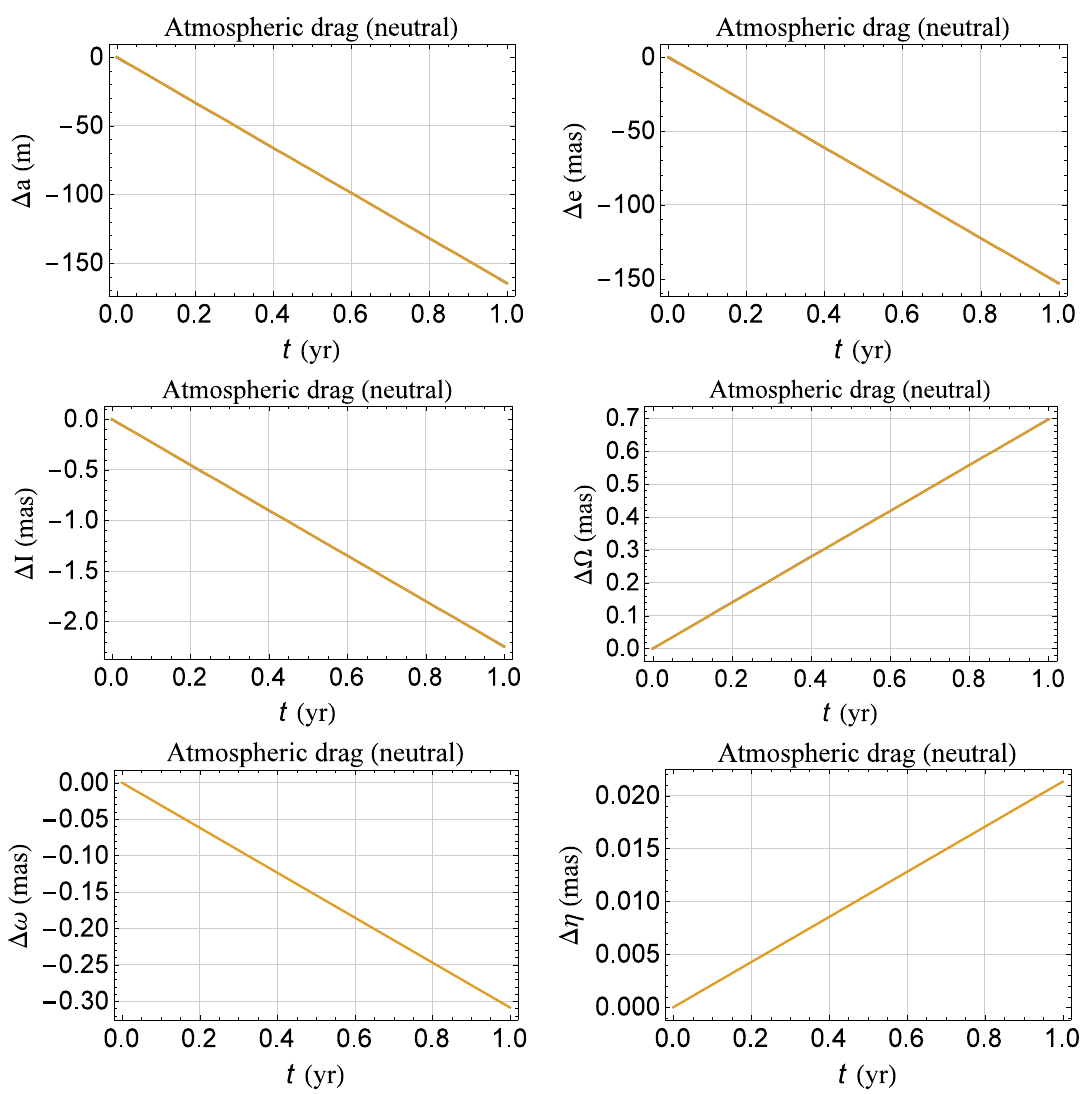
Figure A4. Numerically integrated shifts of the semimajor axis a , the eccentricity e , the longitude of the ascending node Ω , the argument of the perigee ω , and the mean anomaly at epoch η for the orbital configuration of TableA6. For the satellite, assumed spherical in shape and passive, we adopted C D = 3.5, Σ = 2.69 × 10 − 4 as for the existing LARES [53]. In regard to the Earth’s atmospheric density, we adopted r 0 = r min = a ( 1 − e ) = 641.86km, ρ 0 = ρ max = 6.9 × 10 − 14 kgm − 3 , λ = 3463.23km. Cfr. with the semi-analytical results of FigureA3 and Table